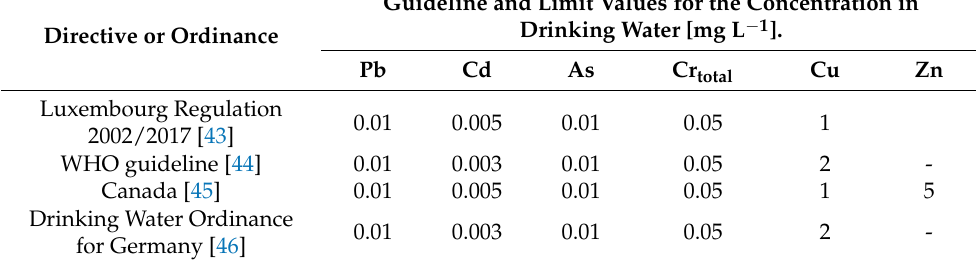
Table 11. Current internationally used guideline and limit values for the concentration of heavy metals in drinking water. Guideline and Limit Values for the Concentration in Drinking Water [mg L − 1 ]. Directive or Ordinance Pb Cd As Cr total Cu